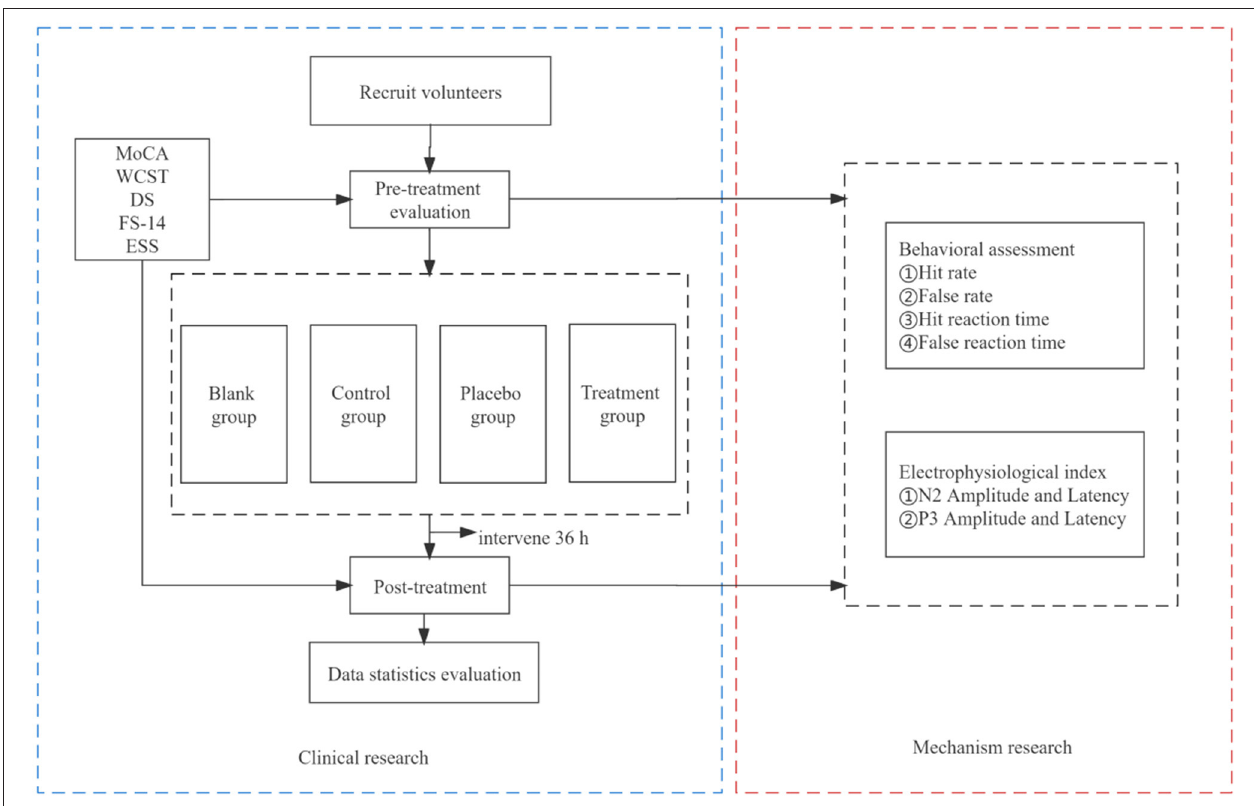
FIGURE 2 | Trial work plan. The primary outcome measure will be MoCA. The remaining outcome measures will be for secondary